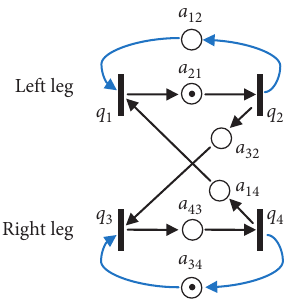
Figure 1: Timed event graph of walking.